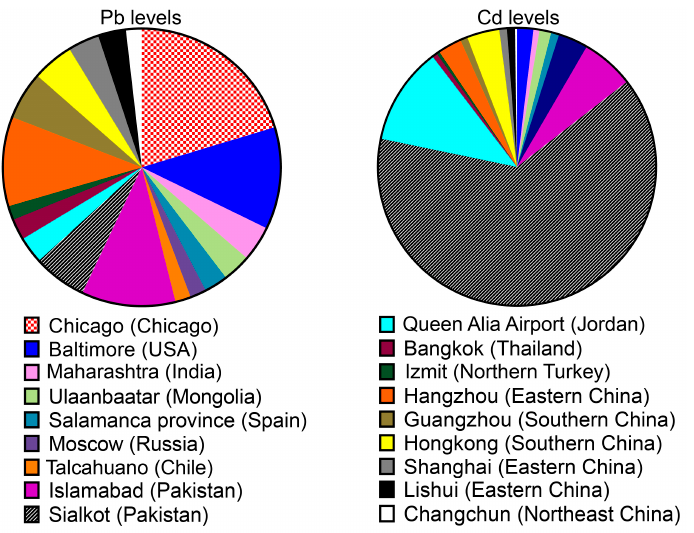
Figure 1. Pb and Cd levels in urban soils of Chinese cities and other cities around the world have been detected. Data are extracted from previous publications.